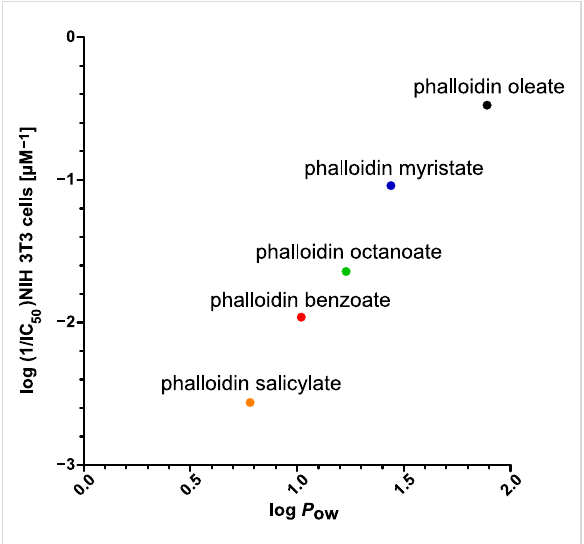
Figure 3: n -Octanol/water distribution coefficients (log P ow ) of the hydrophobic phalloidin derivatives of Figure 2 plotted versus cell toxi- city (log (1/IC 50 ) in NIH 3T3 mouse